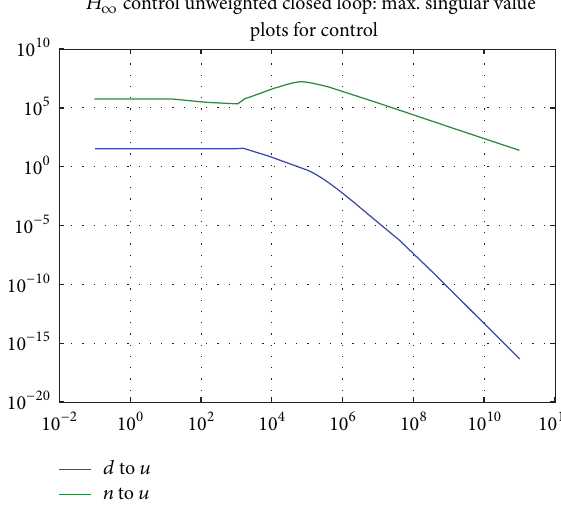
Figure 12: Maximum singular value disturbance to error.